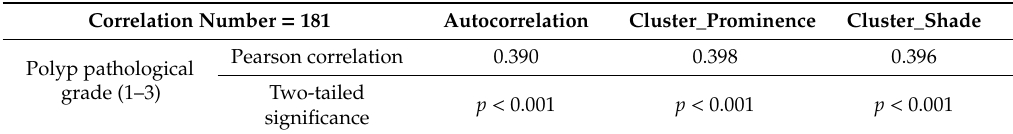
Table 5. All GLCM features and pathology correlation.